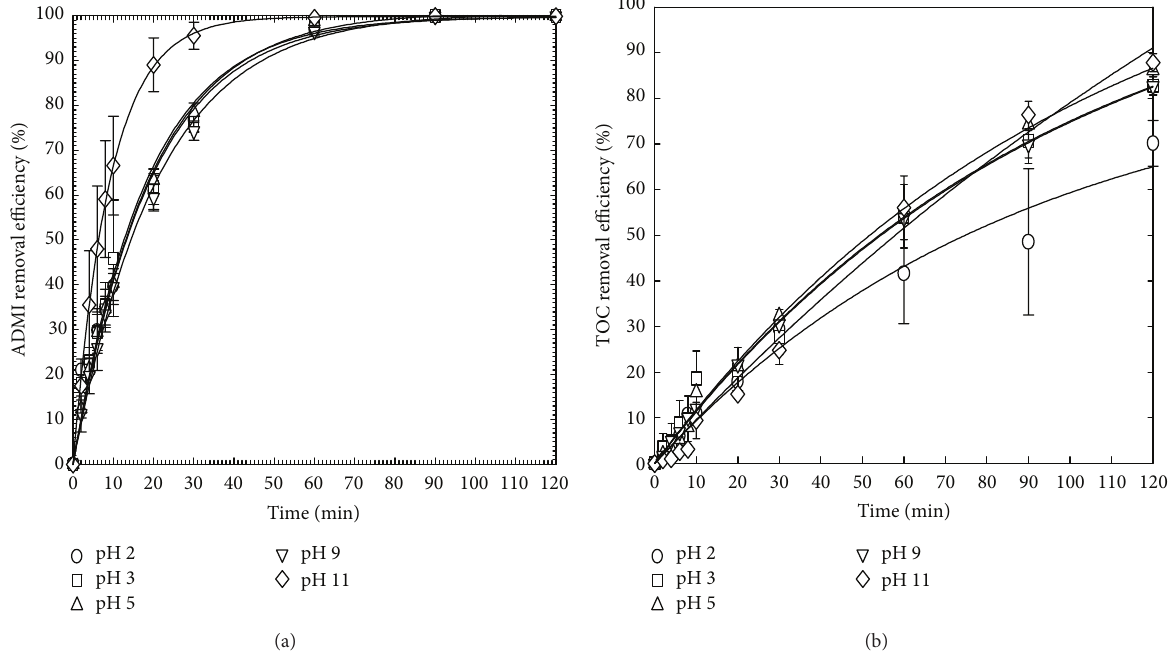
Figure 9: Effect of initial pH on (a) decolorization and (b) mineralization of OG under UV/ZnO system. The conditions were initial dye concentration of 50mgL −1 , ZnO-coated amounts of 60gm −2 , light intensity of 2.1mWcm −2 , and reaction time during 120min.